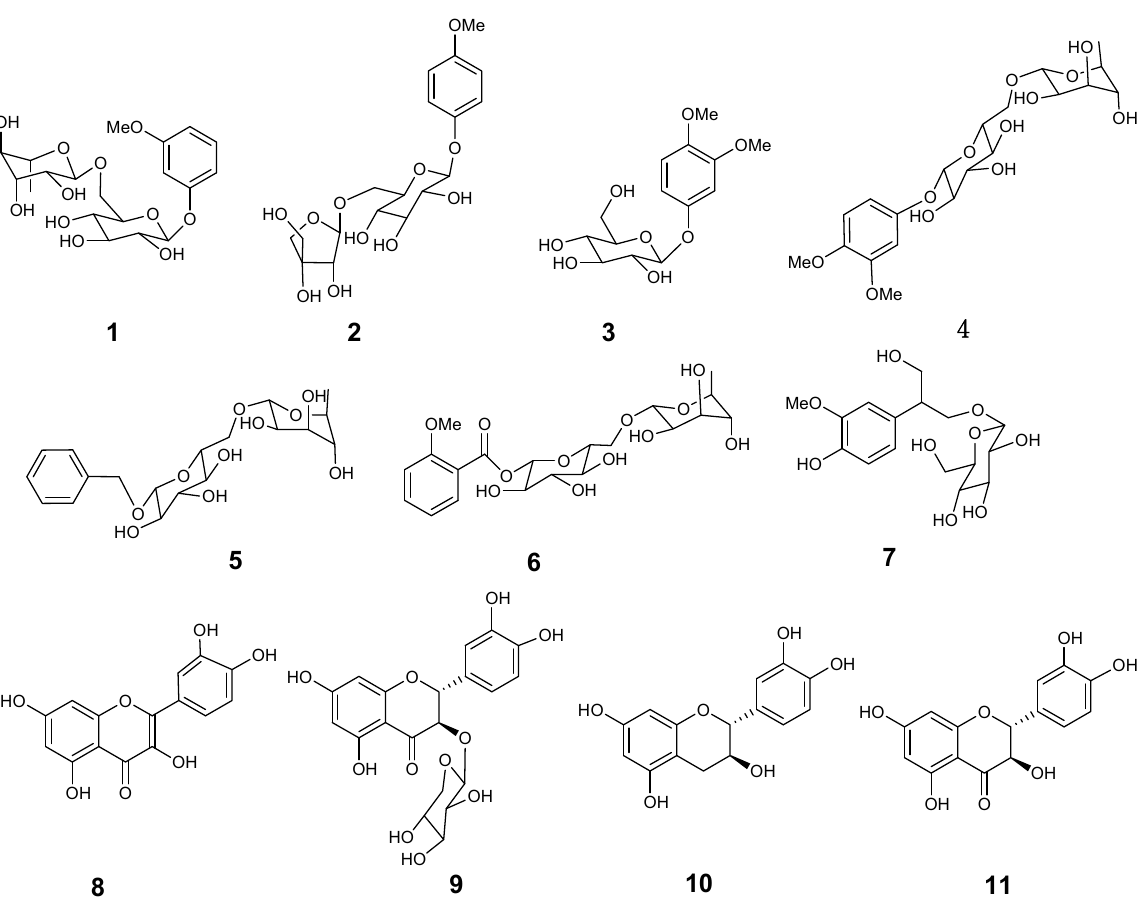
Figure 1. Structures of compounds 1 – 11